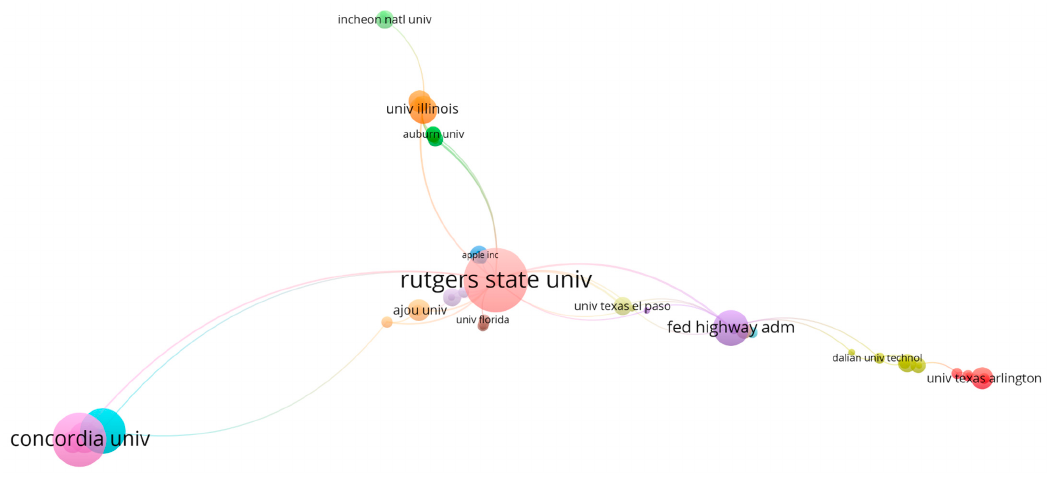
Figure 7. Co-authorship network of institutions in the research on CBD_NDT . Table 2. Quantitative summary of active institutions in the field of CBD_NDT with respect to publication count, total citations and average normalized